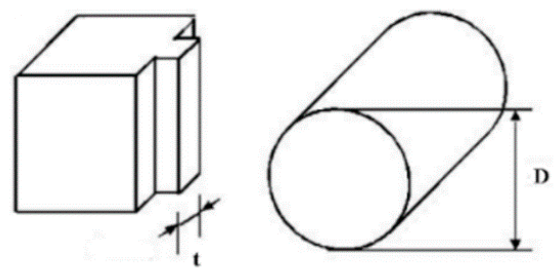
Figure 3. Geometry of the cylindrical pad and flat specimen.